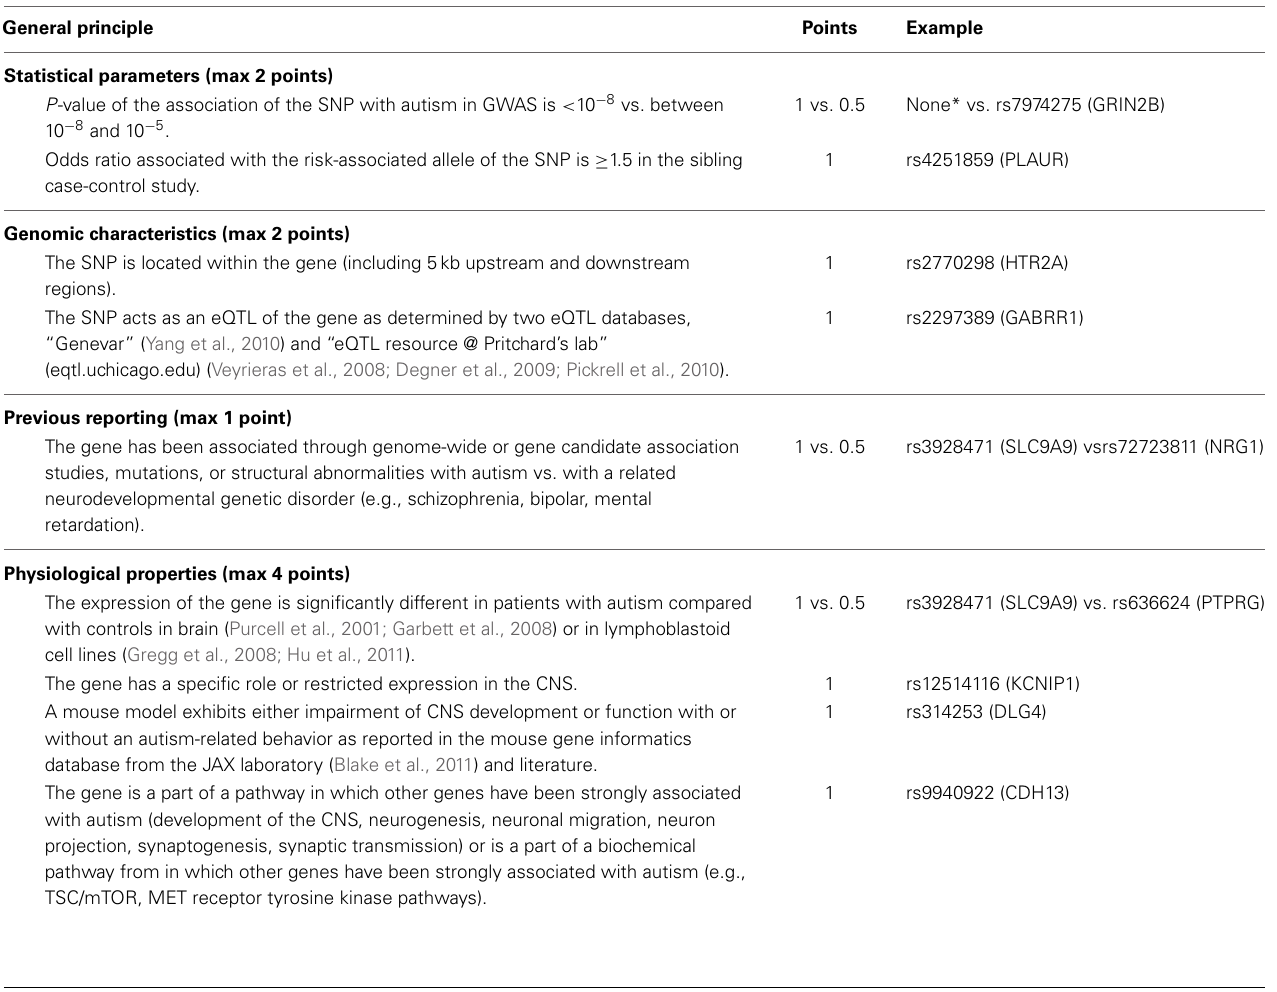
Table 1 | Prioritization and scoring algorithm rules (details are given in Supplementary Table 2) for SNPs selected with P < 0 . 001 in the family-based GWA and P < 0 . 05 in the siblings case-control studies performed in the discovery